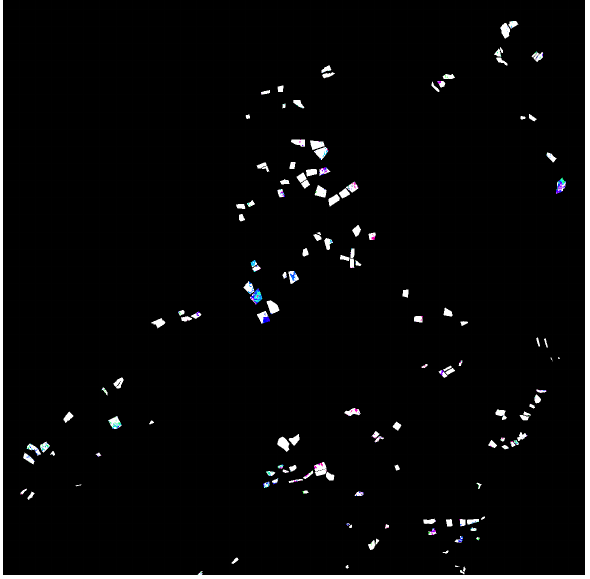
Figure 4. STL-map of the r 2 pattern, for ground truth areas covered by pastures, in the region of la Plaine des Cafres .